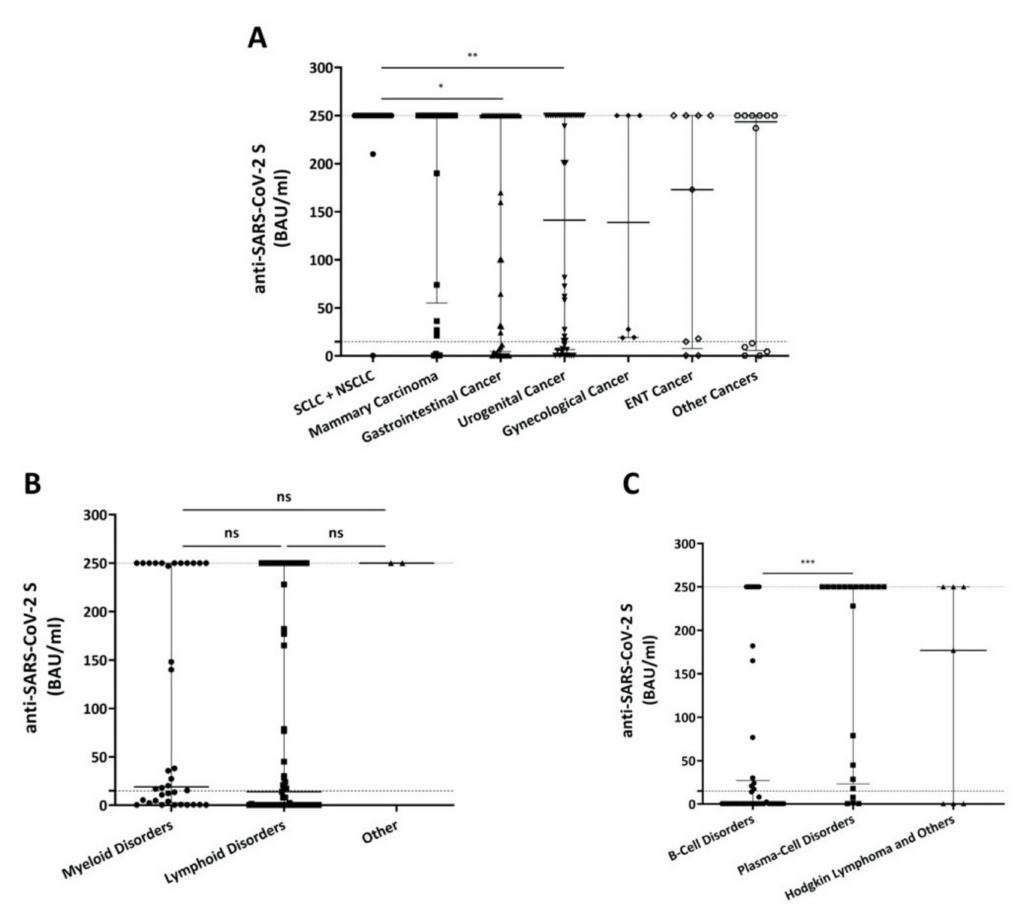
Figure 4. Comparison of antibody levels stratified by type of solid tumor type ( A ) or type of hematologic disease ( B ). ( C ) Comparison of antibody levels after COVID-19 vaccination in hematologic patients with lymphoid diseases grouped by cell of origin of the disease. Threshold (lower dotted line) indicates ≥ 15 BAU/mL; the upper dotted line shows the upper limit of the assay (250.01). Displayed are median values and 95% CI of BAU/mL values (upper and lower ends of error bars). BAU: Binding Antibody Units, SCLC: Small Cell Lung Cancer, NSCLC: Non-Small Cell Lung Cancer, ENT: Ear-Nose-Throat. ns: not significant, * p < 0.05, ** p < 0.01, *** p <